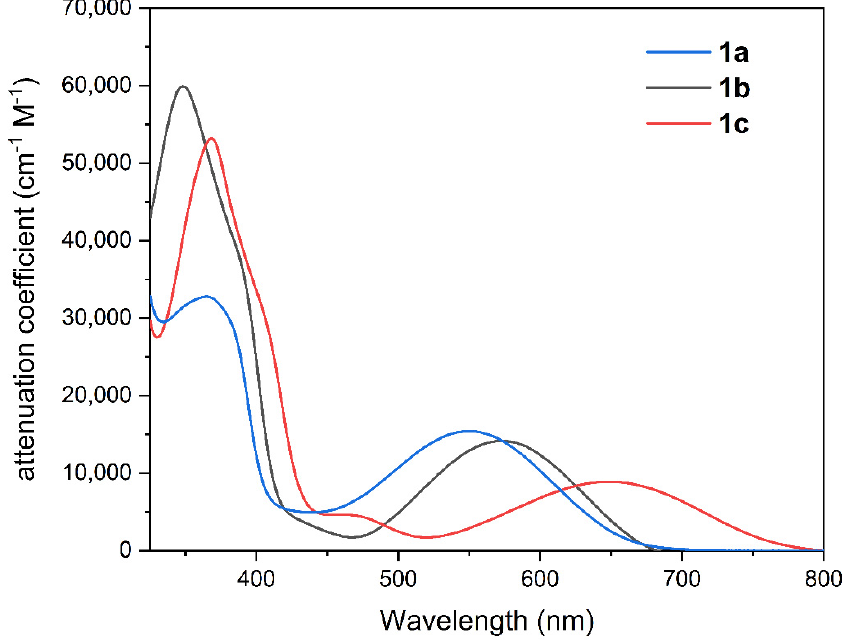
Figure 4. UV-vis absorption spectra of the three compounds in toluene (conc. 0.01 mM). 1a : blue line; 1b : black line; 1c : red line.